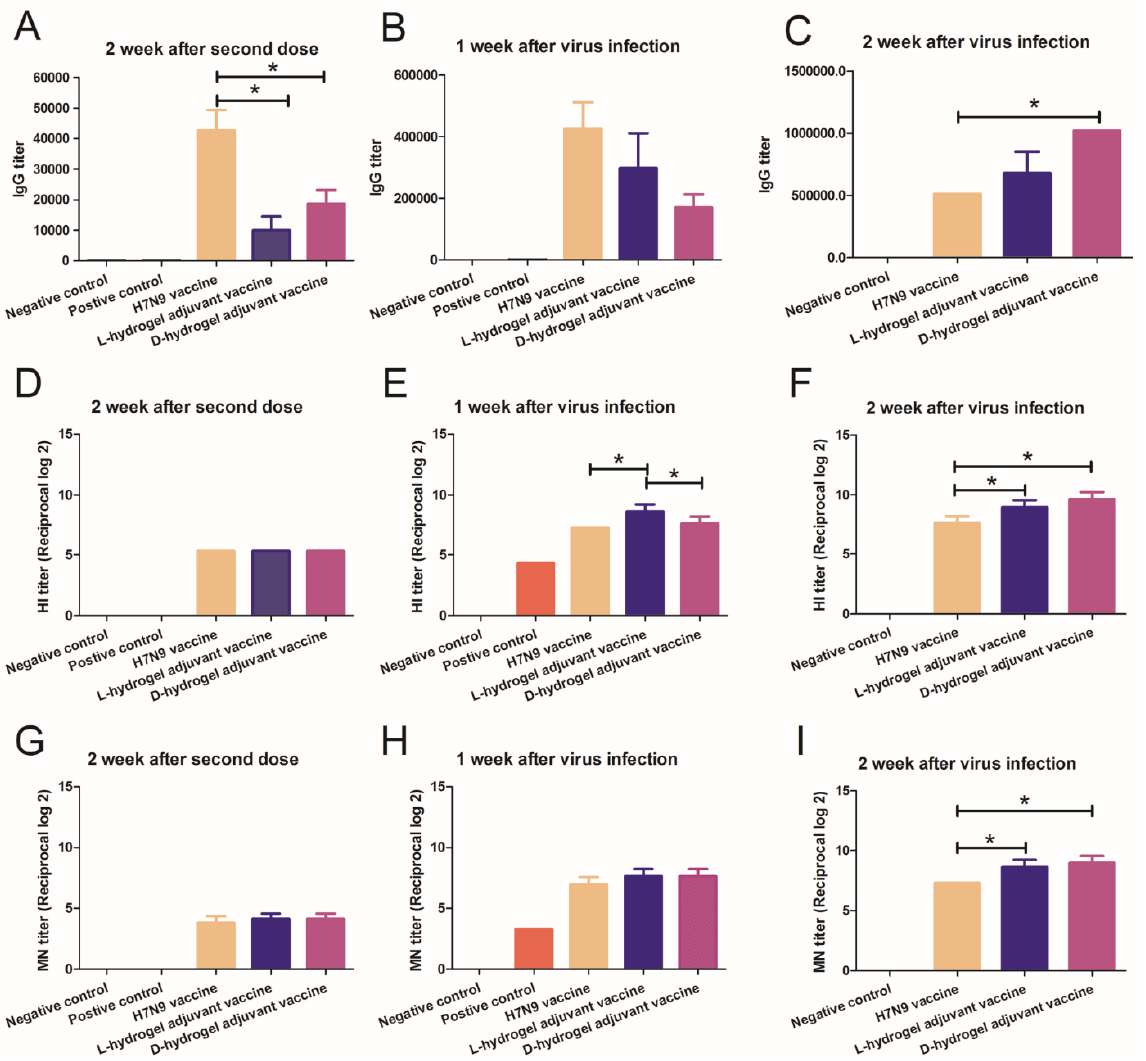
Figure 4. IgG, HI, and MN titers in immunized mice. IgG titer measurements of in the sera of mice immunized with different agents at 2 weeks after the second dose ( A ), at 1 week post virus inoculation ( B ), and at a further 2 weeks post virus inoculation ( C ). HI titer measurements in the sera of mice immunized with different agents at 2 weeks after the second dose ( D ), at 1 week post virus inoculation ( E ), and at a further 2 weeks post virus inoculation ( F ). MN titer measurements of sera of mice immunized with different agents at 2 weeks after the second dose ( G ), at 1 week post virus inoculation ( H ), and at a further 2 weeks post virus inoculation ( I ). An asterisk (*) represents a p value 0.05.